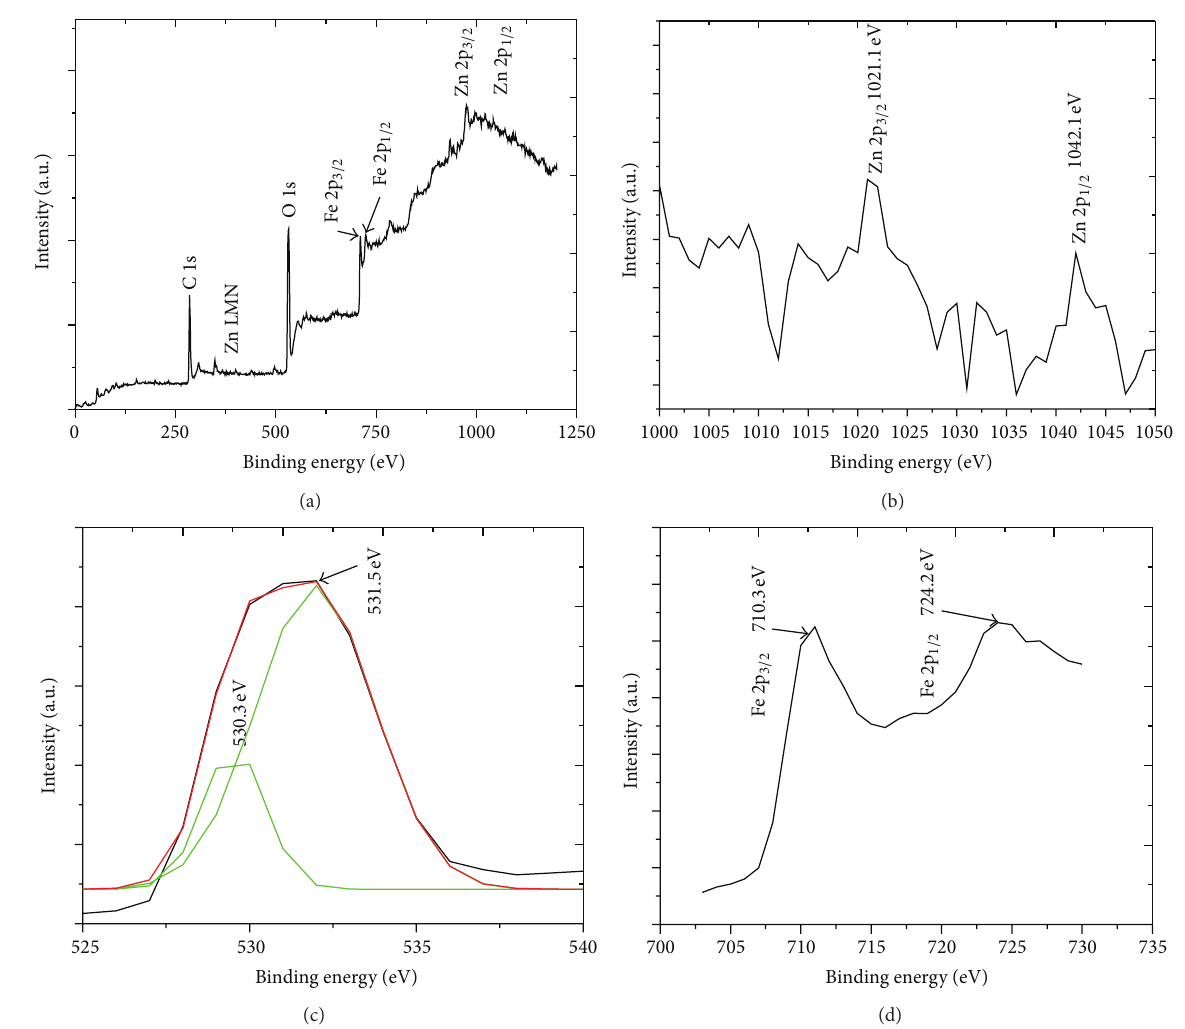
Figure 8: XPS spectra of the ZnO NRs grown on stainless steel wire (a) wide scan, (b) Zn 2p, (c) O 1s and (d) Fe 2p.